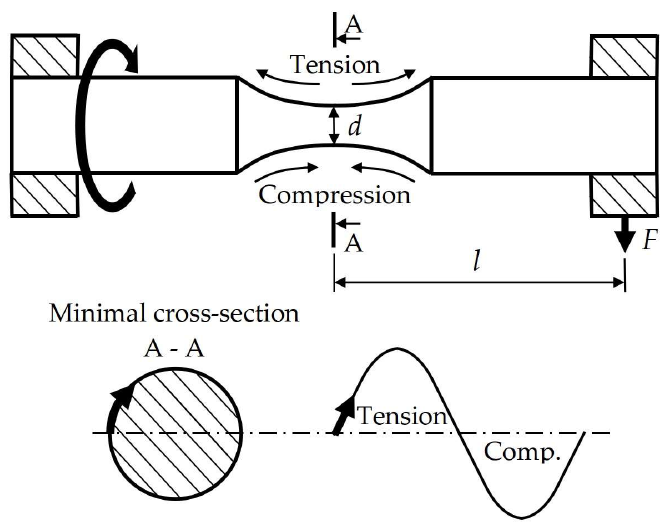
Figure 2. Illustration of stress realization by SM1090V rotating bending fatigue machine. After the printing process, the dimensions of a part were measured using a caliper because they can be modified after being printed. The hourglass specimen with 64 mm in